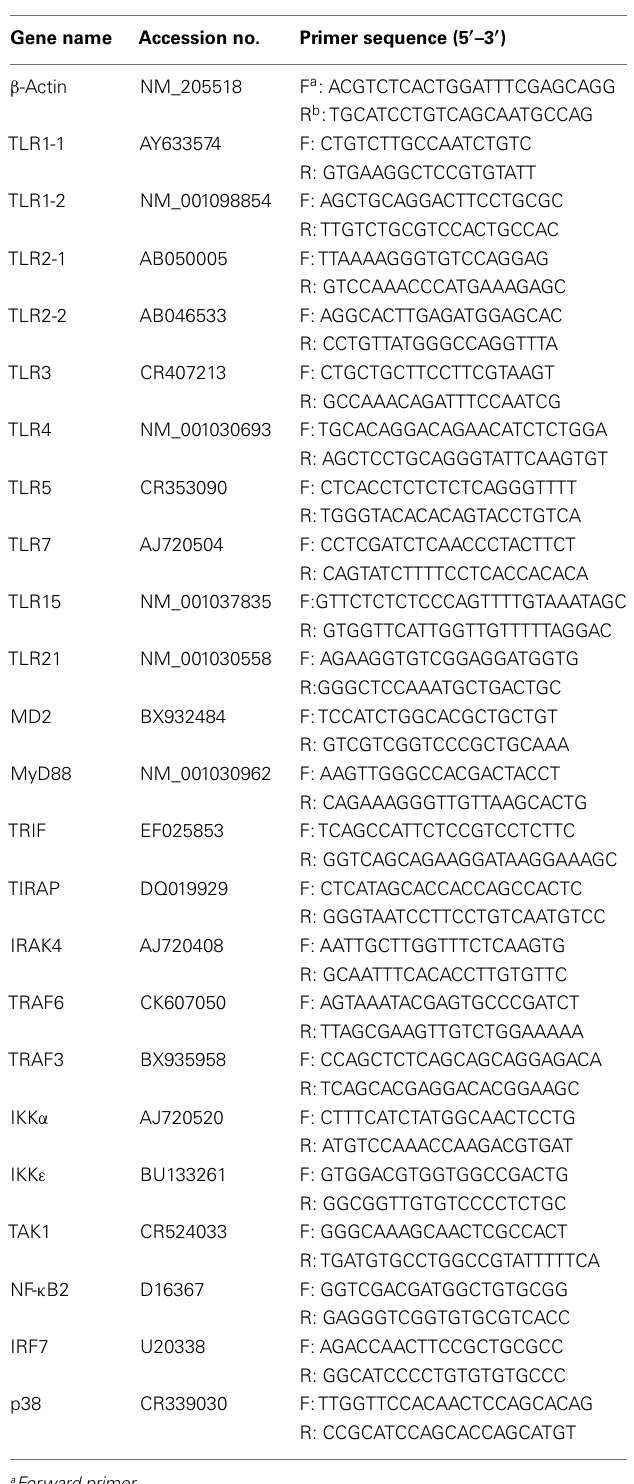
Table 1 | Primers used for